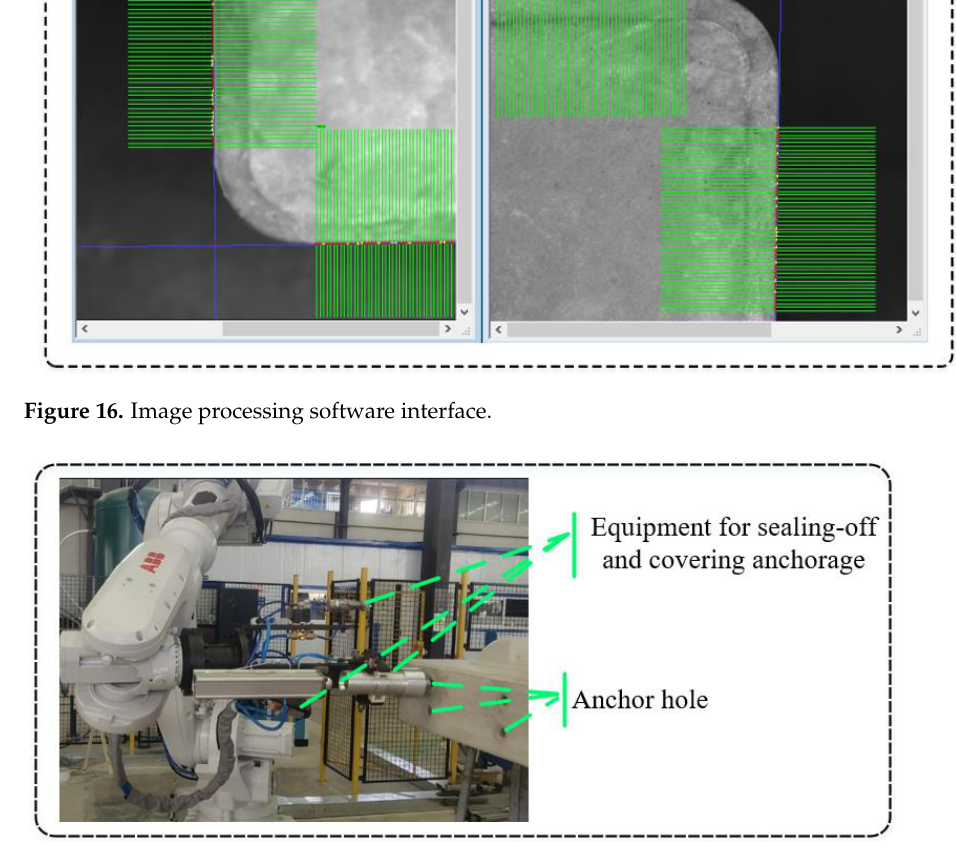
Figure 17. Vision system guides six-axis robot to seal anchor.